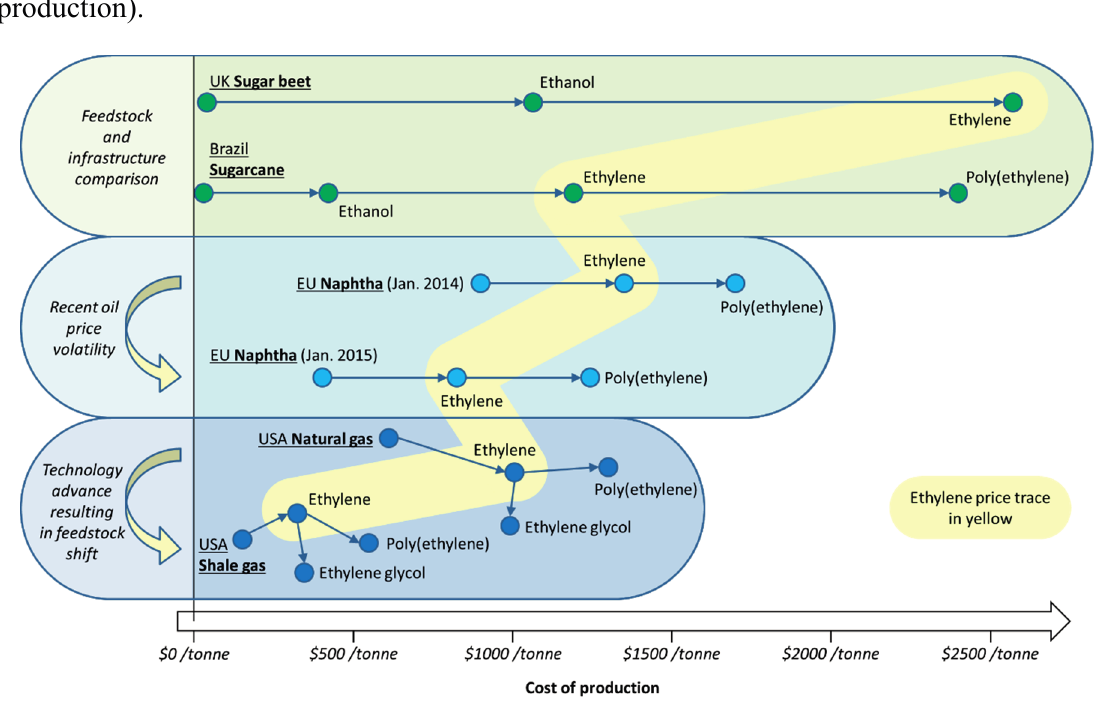
Figure 11. Cost diagram for ethylene feedstocks and representative downstream products